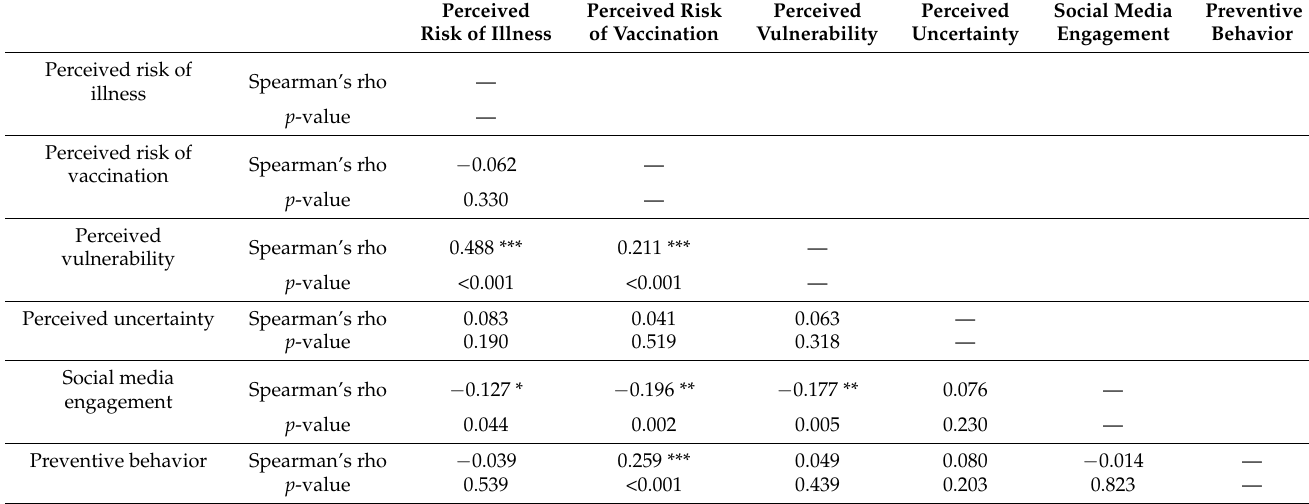
Table 7. Correlation matrix of cognitive and behavioral factors. Perceived Perceived Risk Risk of Illness of Vaccination